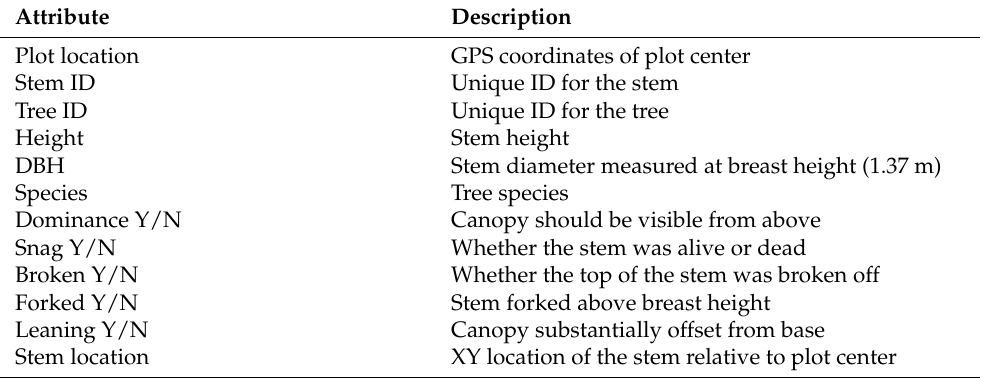
Table 2. Ground-truth attributes measured in the Nooksack River riparian zone, summer 2019. In the context of this study, a stem was defined as a discrete trunk ≥ 10 cm in diameter at breast